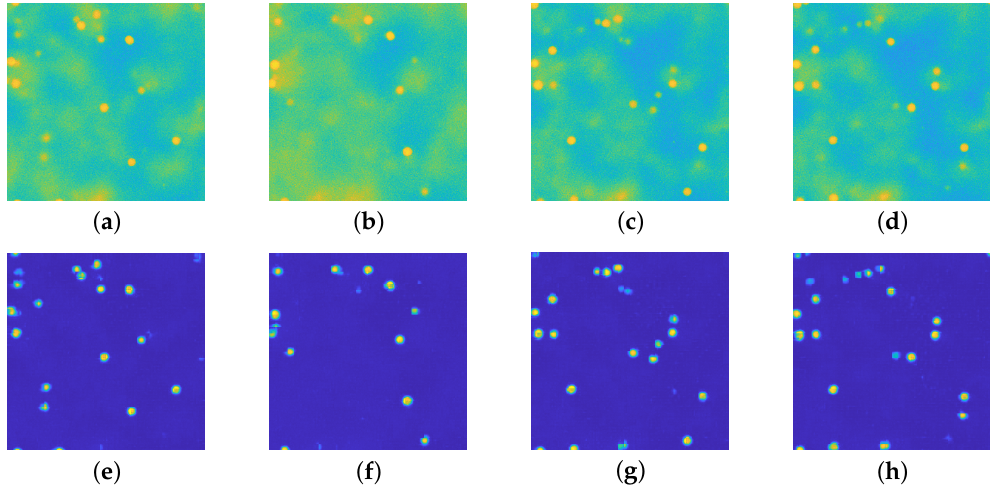
Figure 12. ( a – d ): registered images displayed in [ 0,255 ] . ( e – h ): recovered images via the upU-net architecture displayed in [ 0,255 ] . The fluorescence has been successfully removed and the particle position is evident from the restored